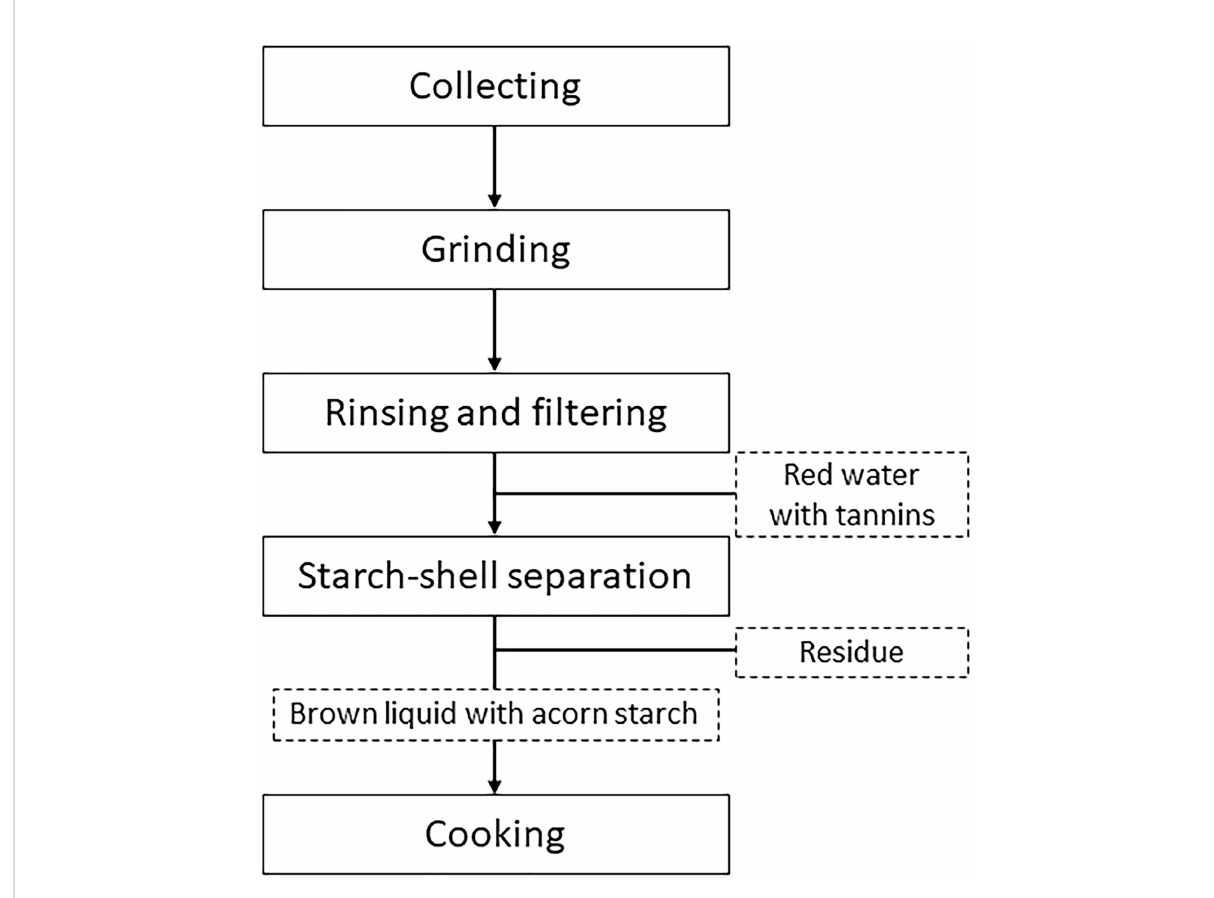
FIGURE 4 Cha ı ̂ ne Ope ́ ratoire of ‘ mook making ’ in our